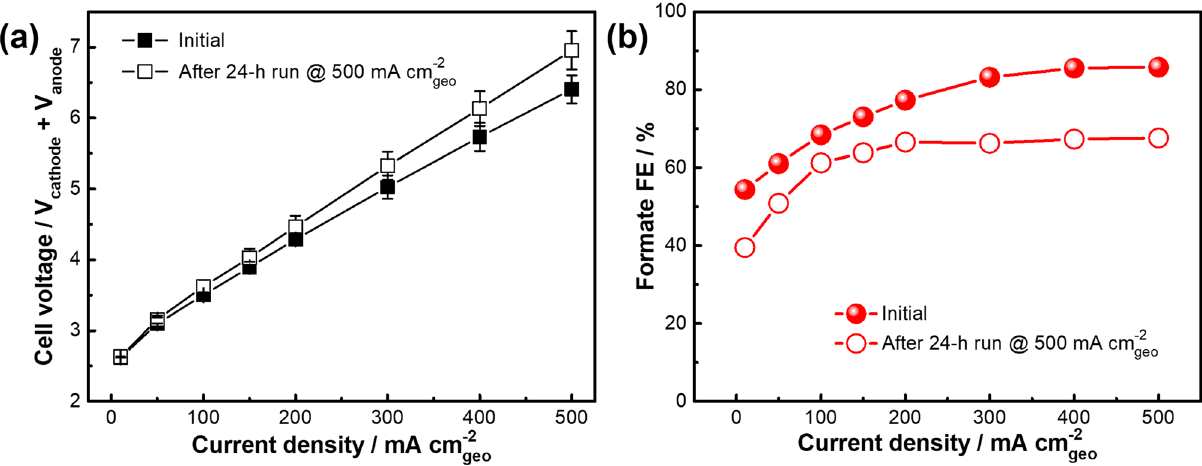
Figure 4. ( a ) MEA full cell polarization curves collected before and after a 24-h electrolysis at 500 mA cm geo−2 . ( b ) Corresponding formate FEs vs. geometric current density. The MEA full cell contained a 5 cm × 5 cm cathode GDE decorated with SnO 2 nanospheres, a Ni foam anode, and a bipolar membrane with aqueous 0.4 M K 2 SO 4 catholyte and aqueous 1 M KOH